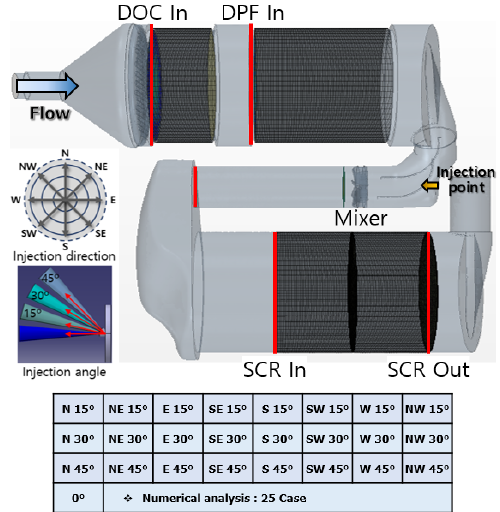
Figure 7. Design candidates for optimizing the UI: eight injection directions, three injection angles, and base